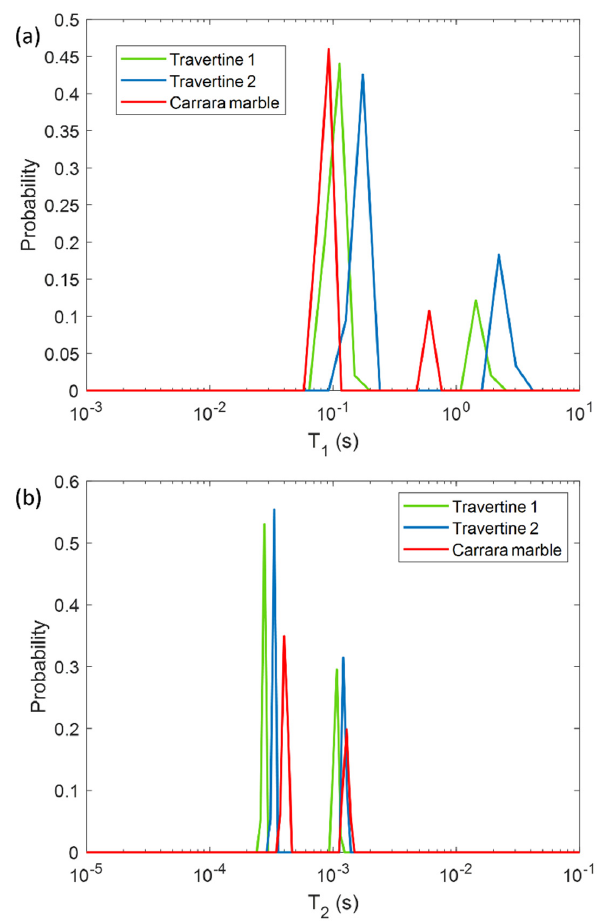
Figure 1. Longitudinal relaxation time T 1 ( a ) and transversal relaxation time T 2 ( b ) distribution for the three untreated samples analyzed in this study: two Travertines (green and blue lines), and one Carrara marble (red line). Travertine 1 refers to the untreated sample before being soiled with corrosion products from penny, whereas Travertine 2 and Carrara marble refer to the untreated samples before being soiled with corrosion products from euro cents.